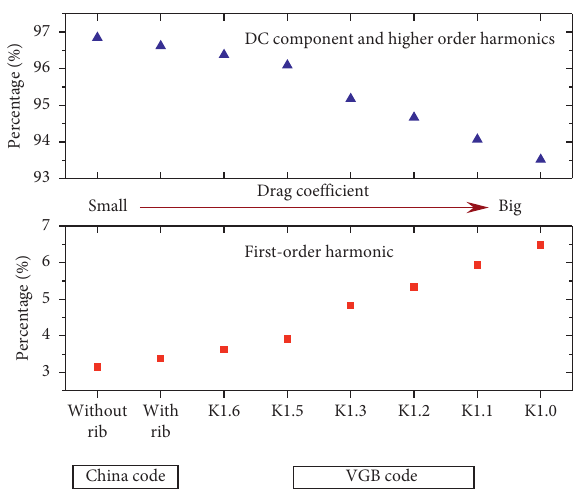
Figure 19: Percentage of first-order and high-order harmonic displacement (middle